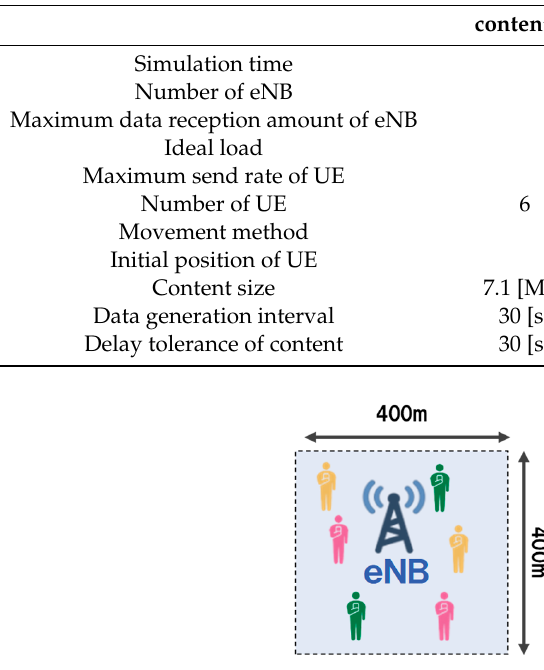
Figure 7. Topology of performance